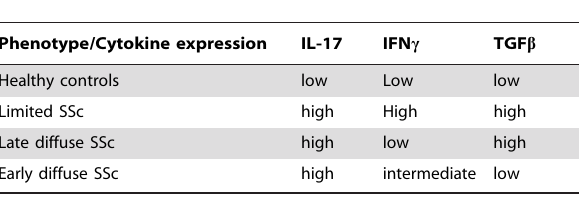
Table 2. Cytokine expression pattern in SSc clinical phenotypes.